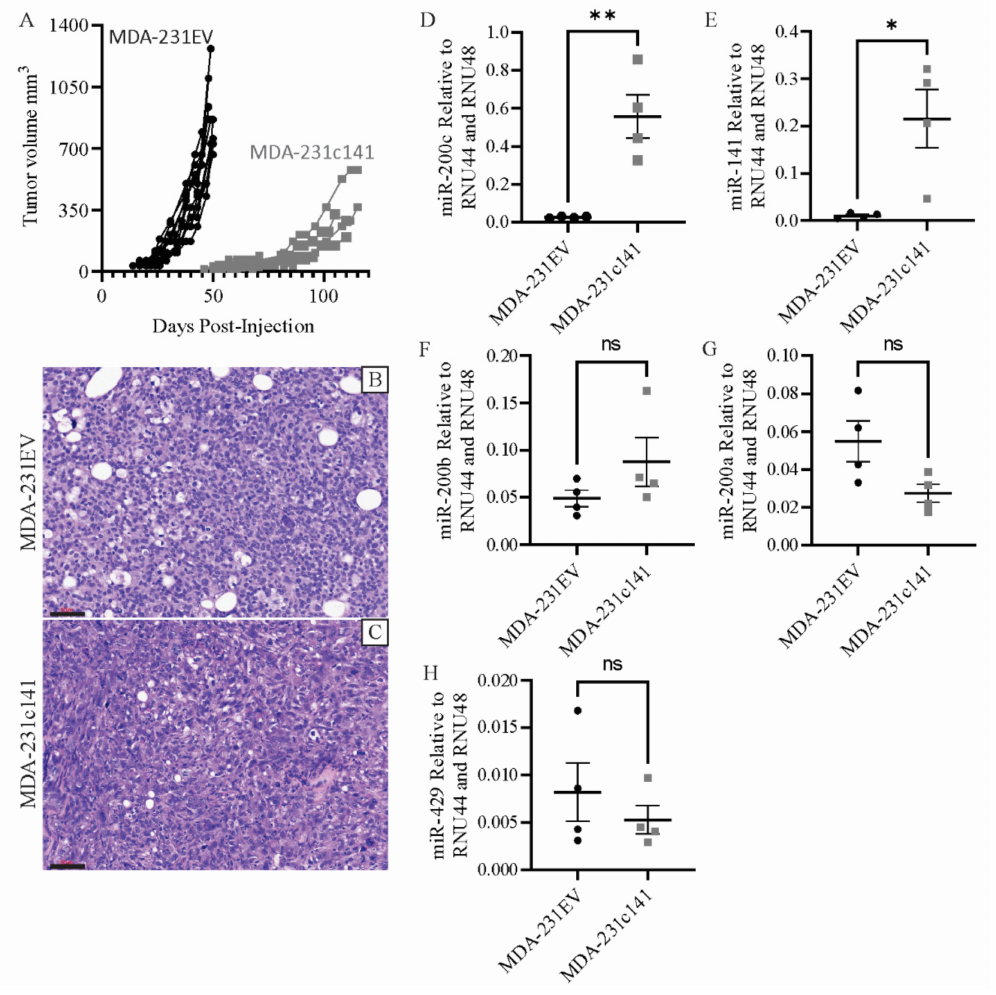
Figure 1. Mammary tumor growth curves for ( A ) MDA-MB-231 cells transfected with an empty vector (MDA-231EV) or the miR-200c/141 cluster (MDA-231c141). Hematoxylin and eosin stained sections of tumors from ( B ) MDA-231EV or ( C ) MDA-231c141 injections. Scale bars are 60 µ m. Expression of ( D ) miR-200c, ( E ) miR-141, ( F ) miR-200b, ( G ) miR-200a, and ( H ) miR-429 in the tumors induced by MDA-231EV or MDA-231c141 injections. miR-200 values were normalized to RNU44 and RNU48. The individual values have been indicated along with the mean ± SEM. A Student’s t -test was performed and significance is indicated as * p < 0.05, ** p < 0.01, ns, not significant. Table 1. Metastatic frequency of MDA-231EV and MDA-231c141 tumors. Lung Pancreas/Spleen